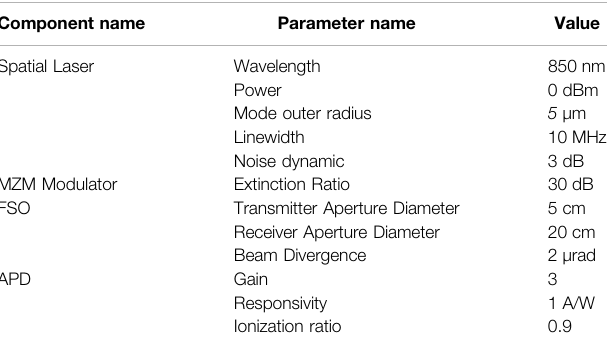
TABLE 2 | MDM-PDM-Ro-FSO modeling